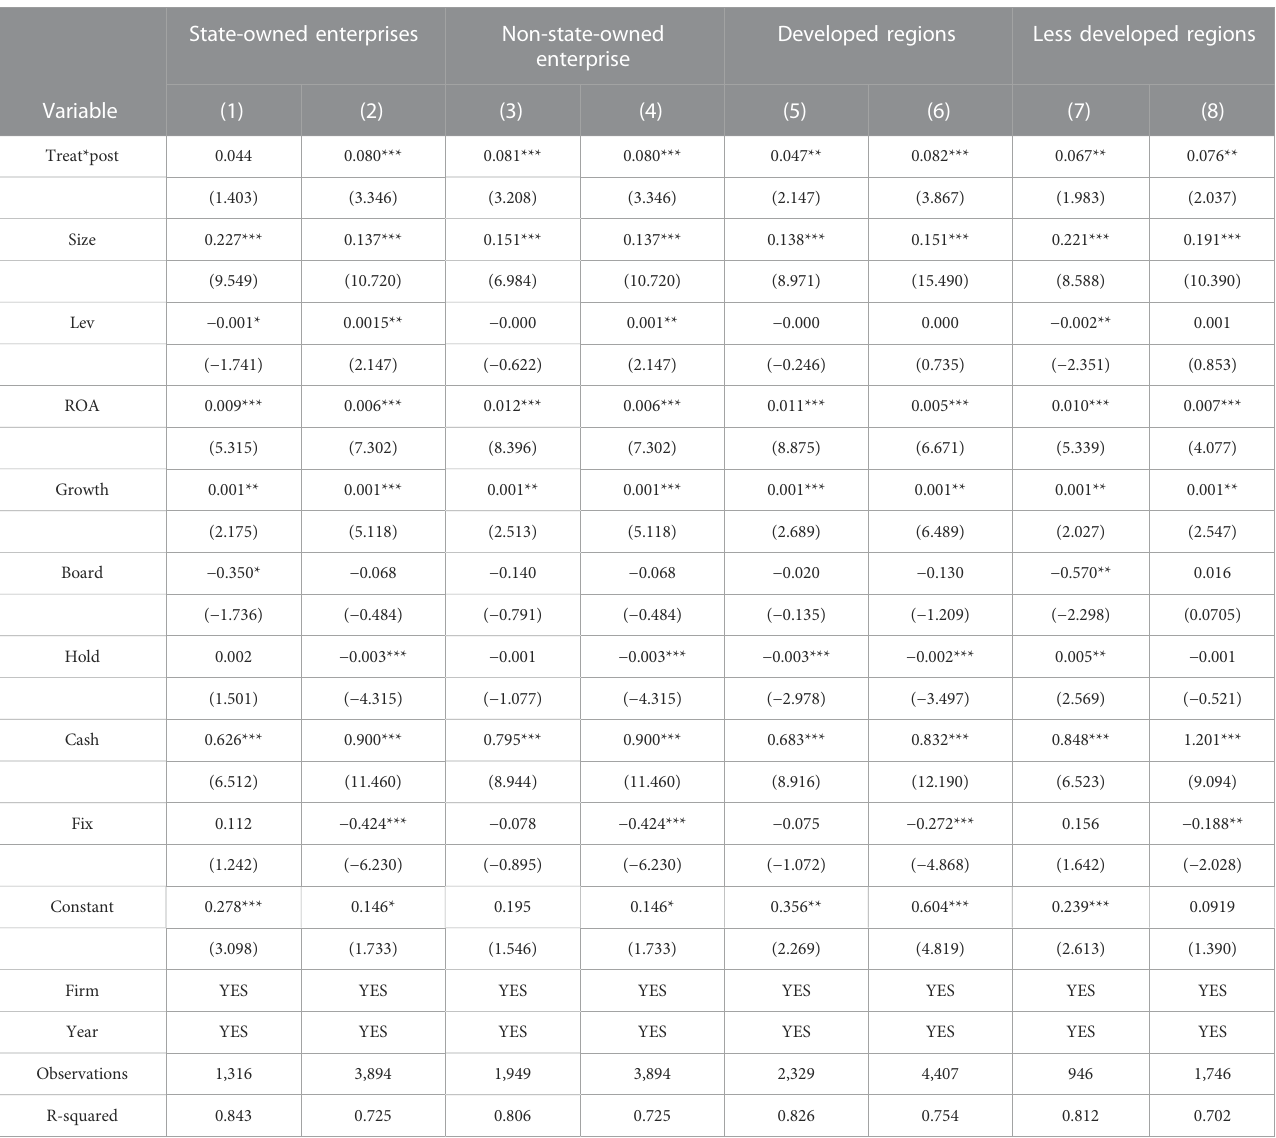
TABLE 8 Regression results of heterogeneity